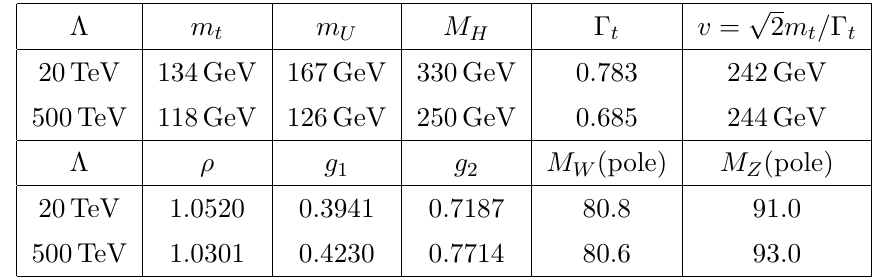
Table 1 . The fermion masses, Higgs boson mass, (cid:26) -parameter, SU(2) (cid:10) U(1)) EW couplings and the W , Z -pole masses calculated for ETC scales (cid:3) = 20 and 500 TeV. The top mass is an input determined by renormalizing from its value of 173 GeV. The Higgs boson’s vev v = determined as a check on the calculation of the (cid:22) tt scattering amplitude in the scalar channel, where (cid:0) 2 ((cid:3)) = 2 is the residue of the Higgs pole. The calculation scheme used is described in ref. [16]. As t noted in the text, the deviations of (cid:26) from one are not reliably